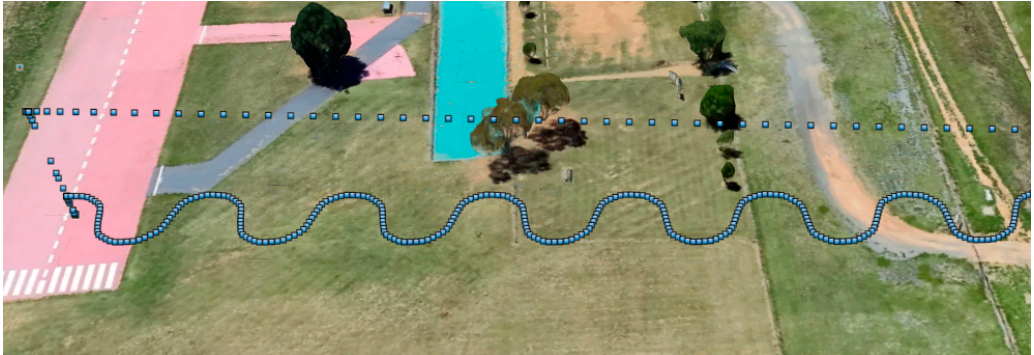
Figure 2. Sinusoidal trajectory performed by the simulated